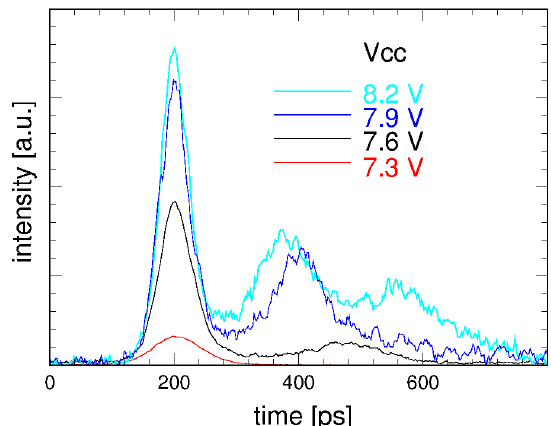
Fig. 5. Light curve of the laser pulses measured by a streak camera. The time resolution of the streak camera is two picoseconds. The amplitude of the applied electric pulses are adjusted by Vcc as indicated in the figure. Results from four Vcc values are shown. 7.3 V is the optimum voltage to extract the first pulse without relaxation oscillations. An 80- picosecond pulse width in FWHM is achieved at this Vcc value. A higher intensity pulse is emitted with the relaxation oscillation when a higher Vcc is applied.